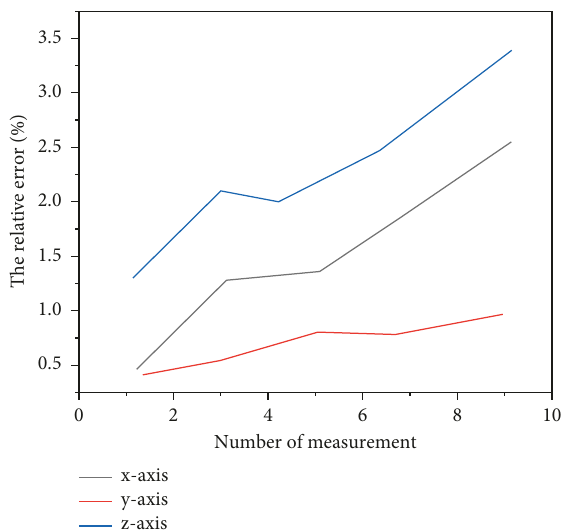
Figure 6: Dimensional errors in three horizontal directions.